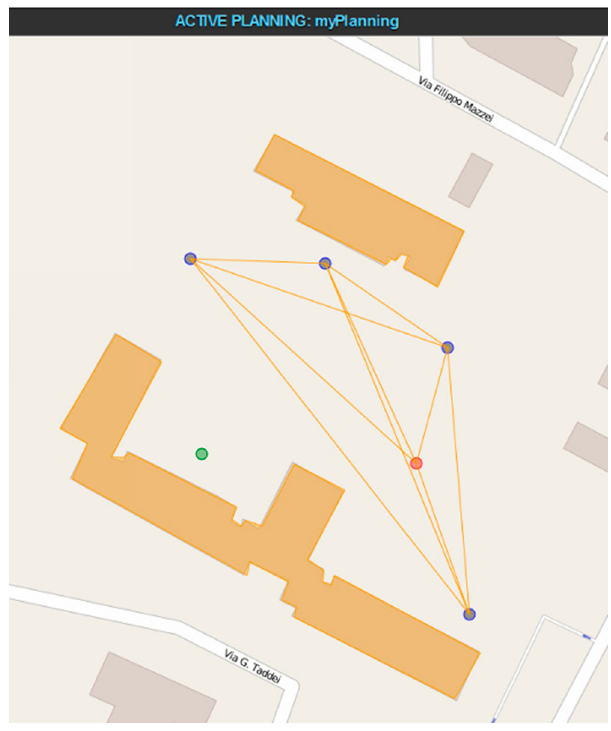
Figure 6. Graphical representation of the connectivity matrix.